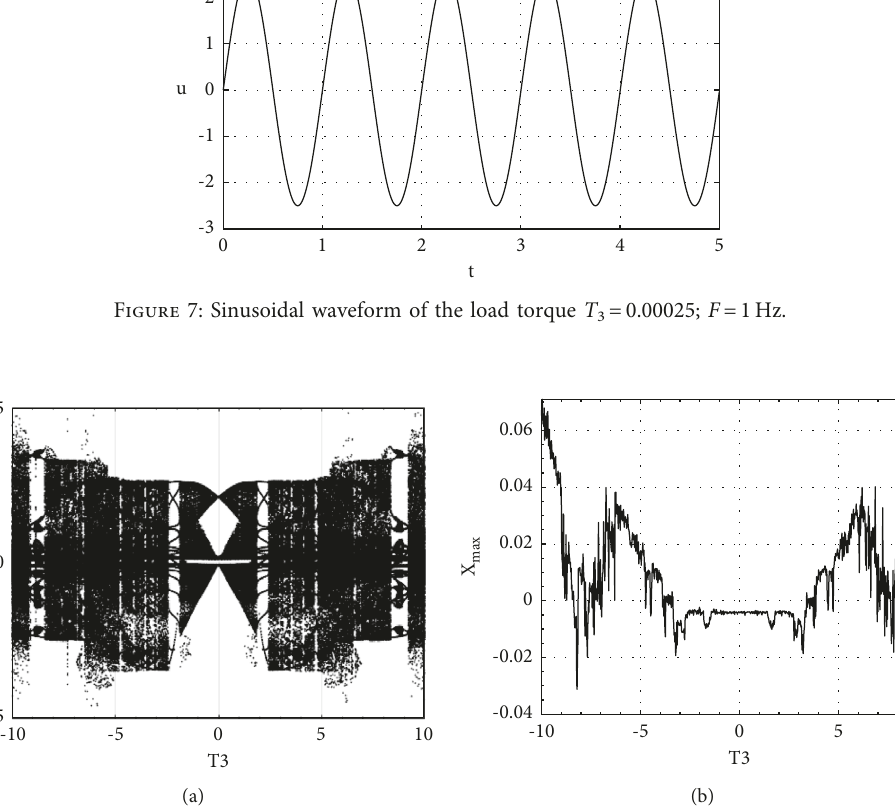
Figure 8: Bifurcation diagram (a) and the corresponding largest Lyapunov Exponent (b) of the PMSM driving a sinusoidal load torque by variation of the amplitude (A) F � 1Hz; initial conditions are ( x 0 � 0.01; y 0 � 0.01; z 0 � 20); and the other parameters of the system are c � 30; u � 0.009; v � 0.005; β � 0.03; σ �